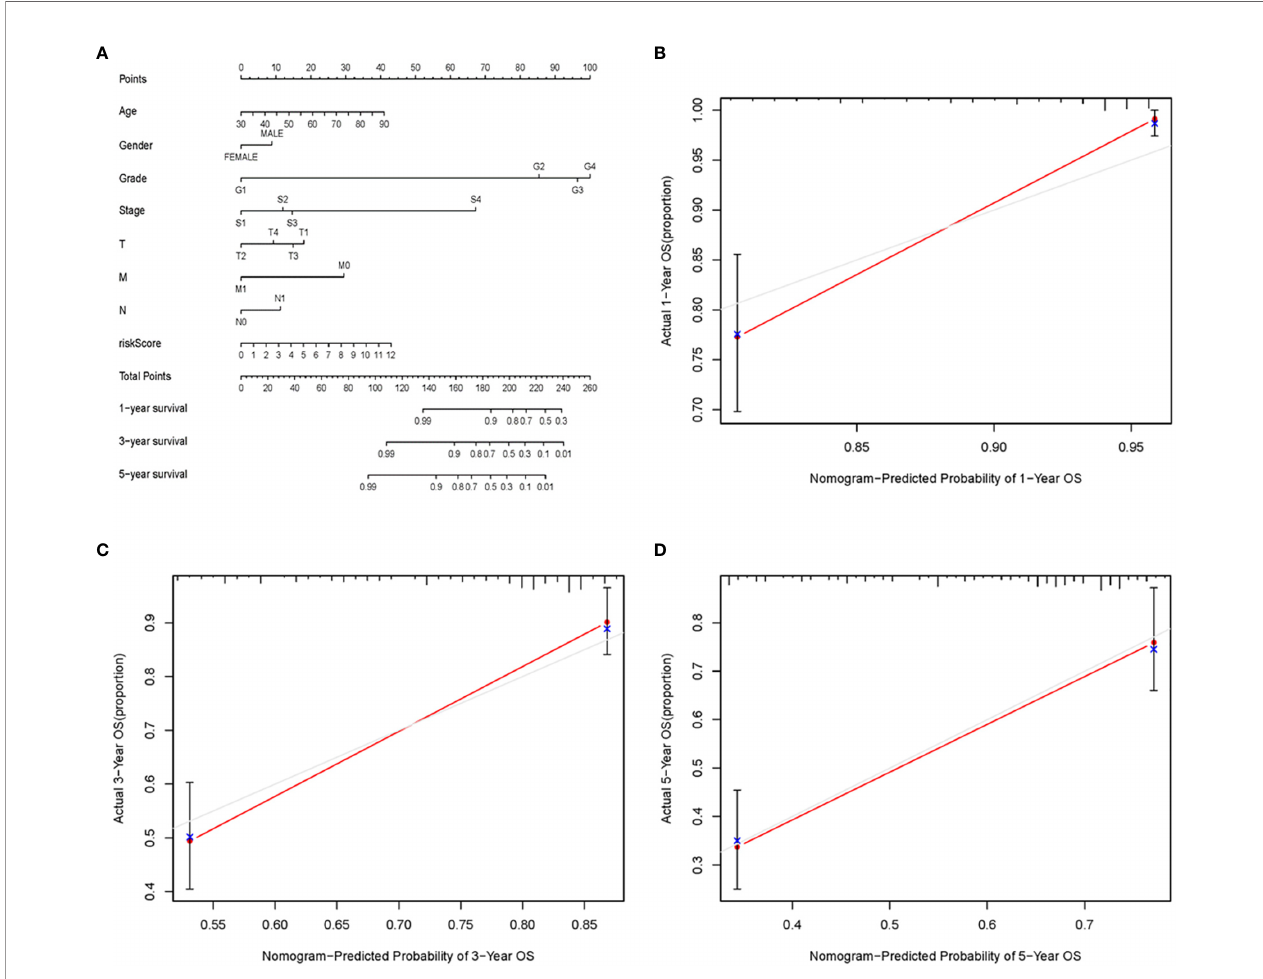
FIGURE 7 | The nomogram and calibration curves of ARRS. Nomogram was used for predicting 1-, 3-, and 5-year survival probability of ccRCC patients (A) . The calibration curves of nomogram of 1 (B) , 3 (C) , and 5 (D)